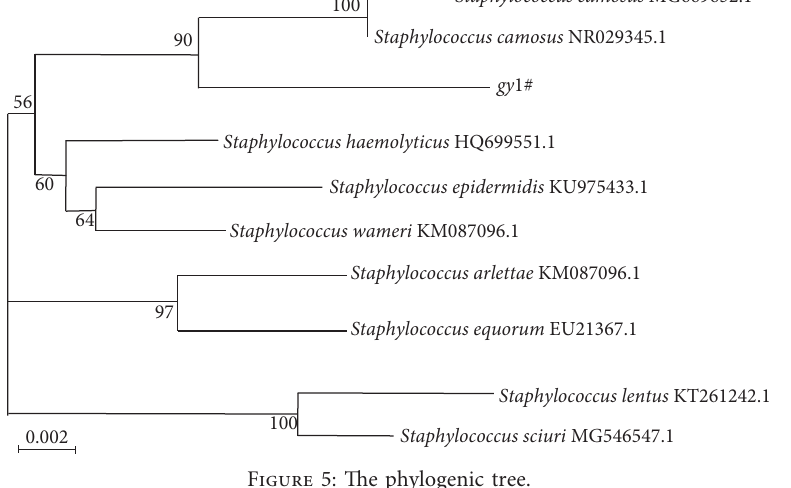
Figure 5: The phylogenic tree.